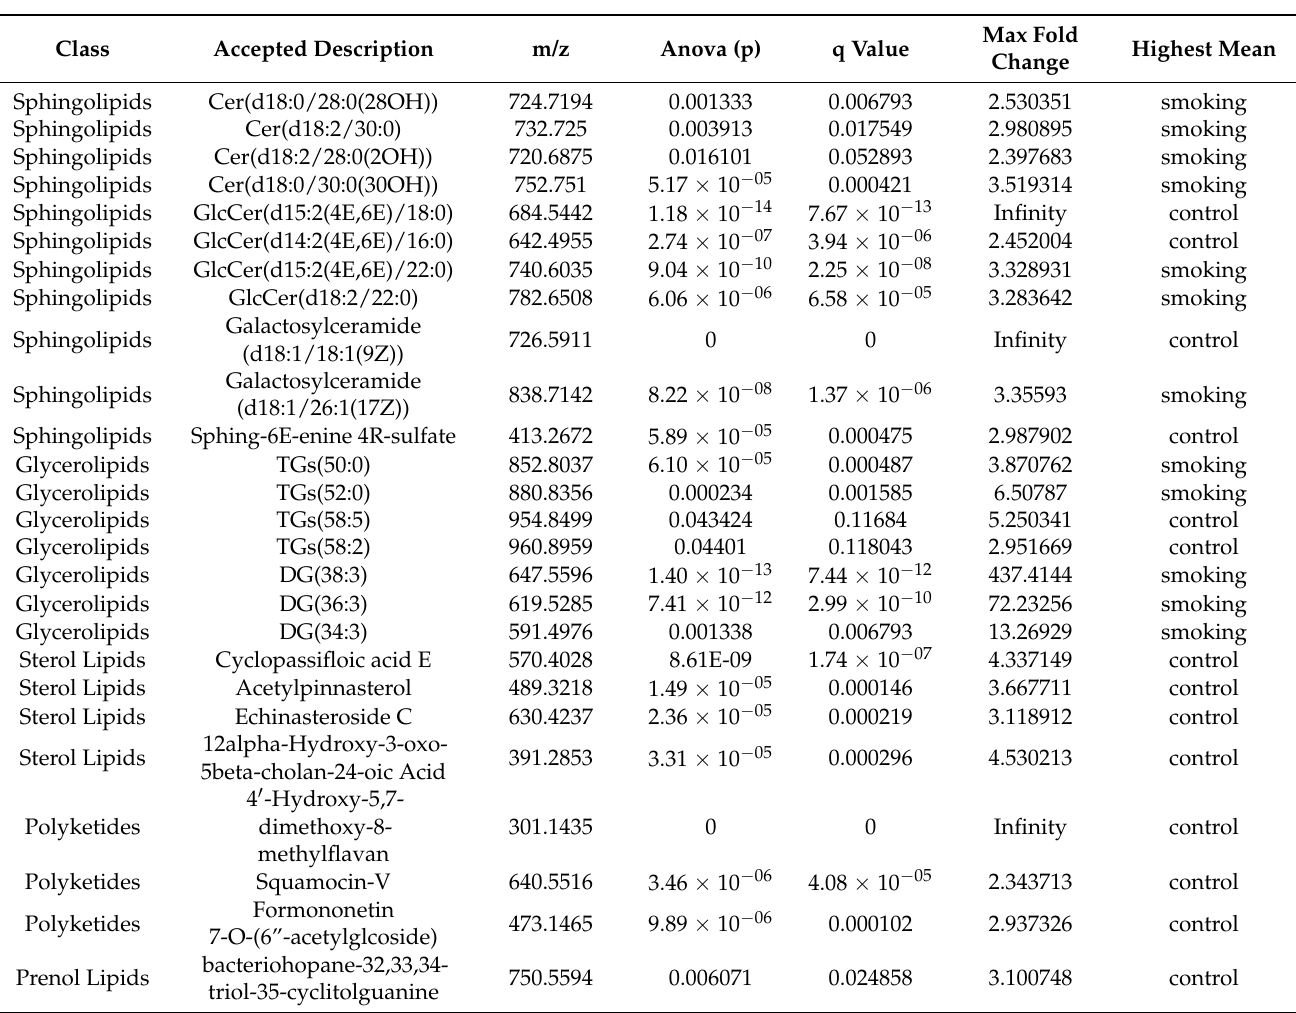
Table 1. Screened individual skin surface lipids (SSLs) considered most important for distinguishing between the smoking and control